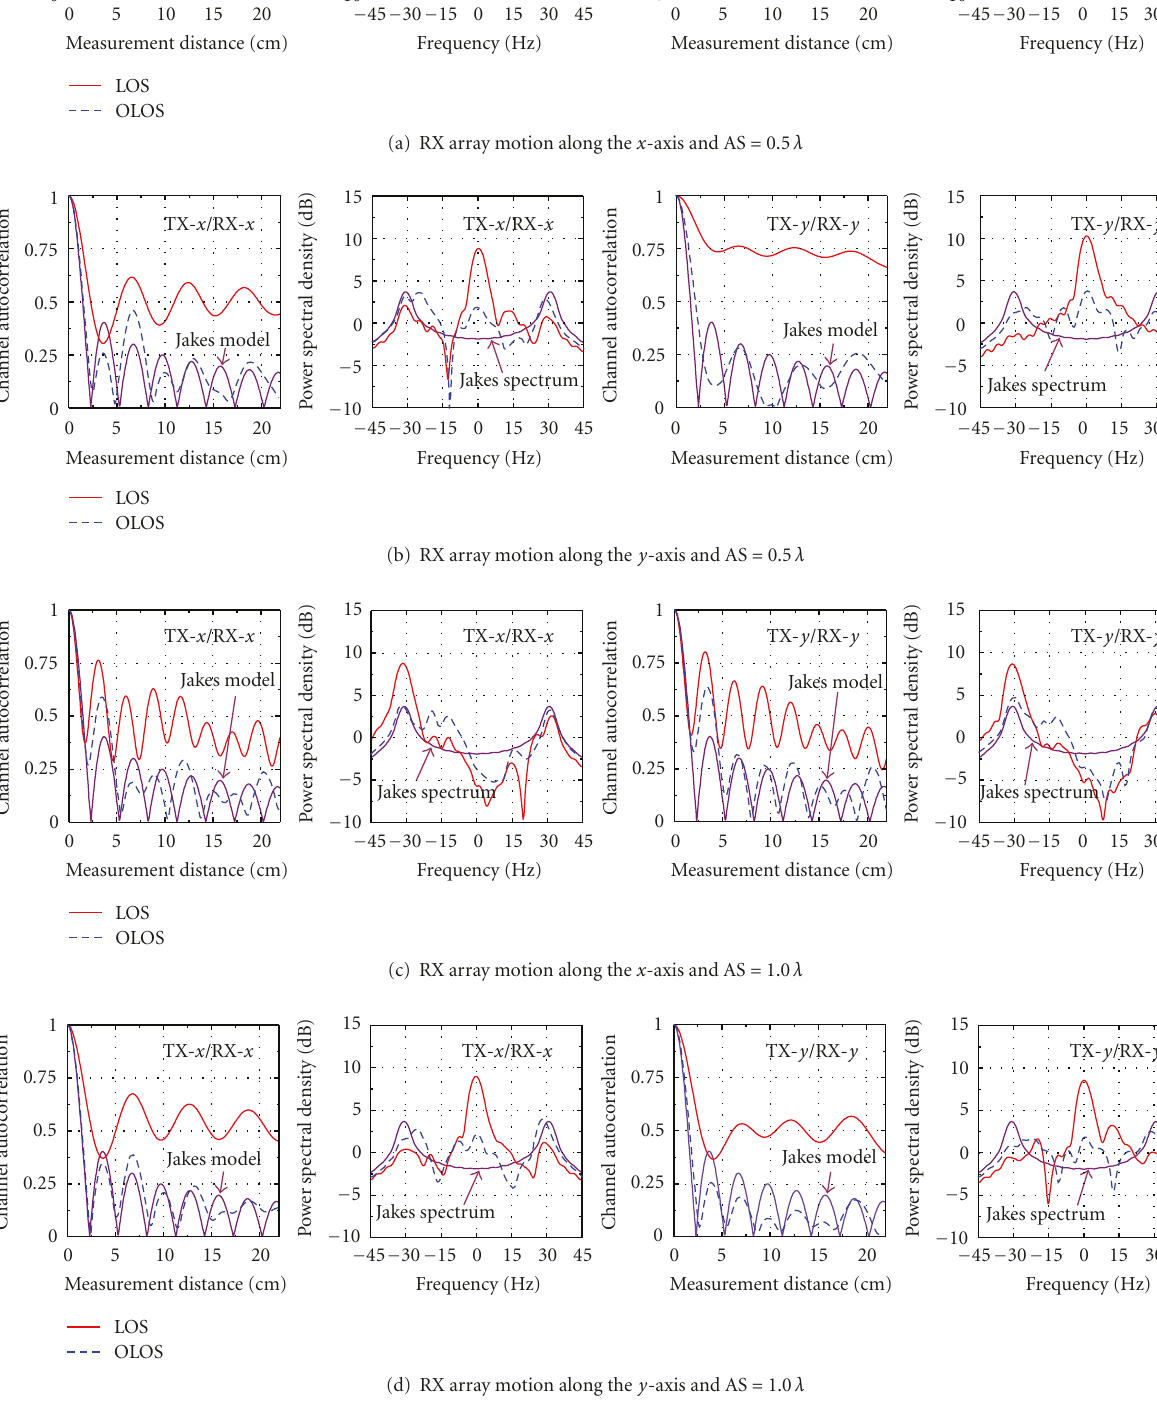
Figure 13: Channel autocorrelation and Doppler spectrum for f D = 31 Hz of 2 × 2 MIMO